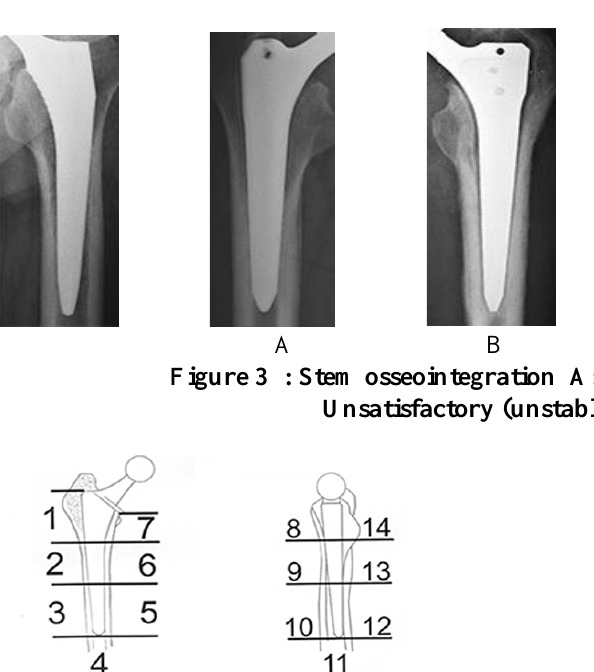
Figure 4 : Projection zones of the endoprosthesis stem on the X-ray picture in the frontal and lateral projections according to the Т.А Gruen classification (14) When evaluating the stability of the cement fixation prosthesis, it must be borne in mind that normally between the prosthesis and the cement mantle, as well as cement and the bone tissue there may be an osteolysis line of 1-2 mm width. It is conditioned by the minimum mobility of the implant in the cement and the whole block in the